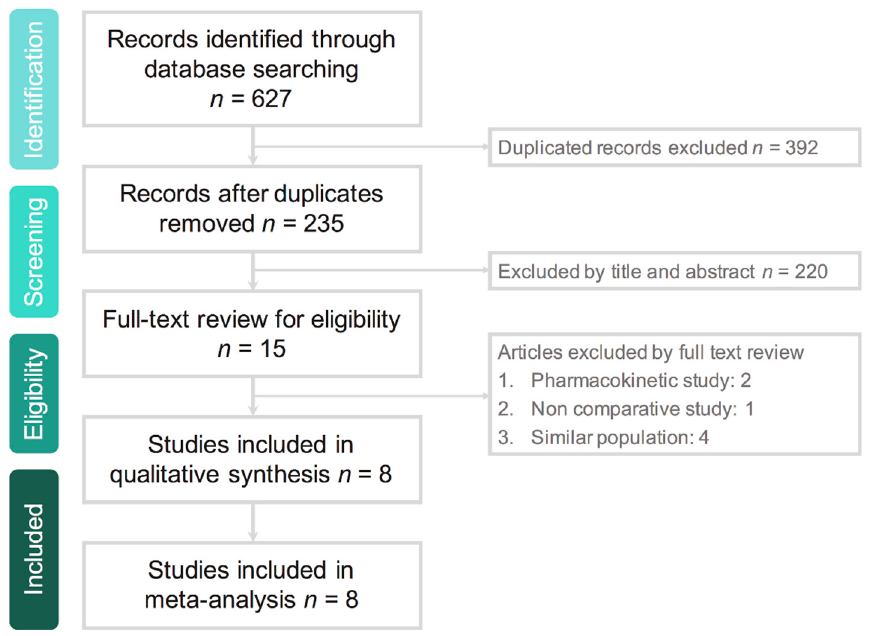
Figure 1. Algorithm for the screening and identification of studies.